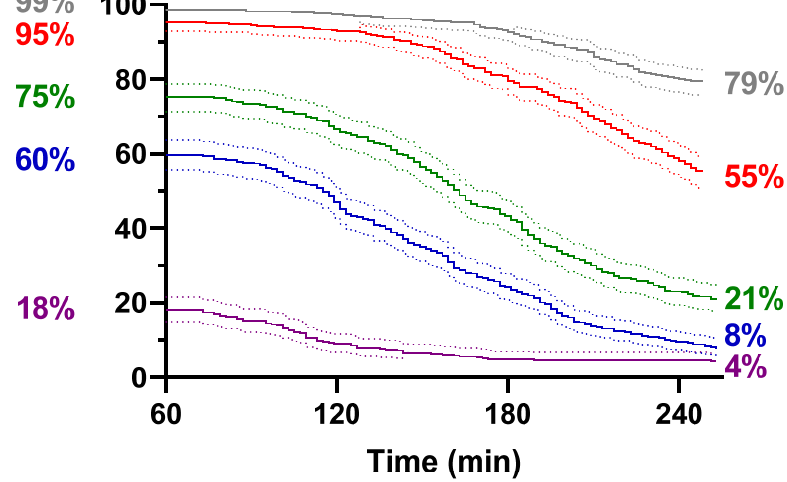
Figure 5. Survival analysis of single yeast cells upon treatment with HsAFP1 evaluated by SYTOX. Yeast cells were treated with 12.5 (grey), 25 (red), 50 (green), 100 (blue) and 300 (purple) µ g/mL HsAFP1 during 3 h treatment on-chip, resulting in 4 h of total treatment at room temperature using DHE and SYTOX to evaluate membrane permeabilization. Images were taken every 2 min. The percentages of SYTOX-negative cells at the start and the end of image analysis are indicated per condition on the left and right, respectively. A minimum of 507 cells was evaluated for every HsAFP1 concentration, originating from 2 independent biological experiments ( n = 2). The log-rank (Mantel– Cox) test, followed by Bonferroni correction to allow for multiple comparisons, was used to evaluate the differences between curves. Dotted lines represent asymmetrical 95% confidence intervals. All treatments resulted in significantly different percentages of SYTOX-negative cells over